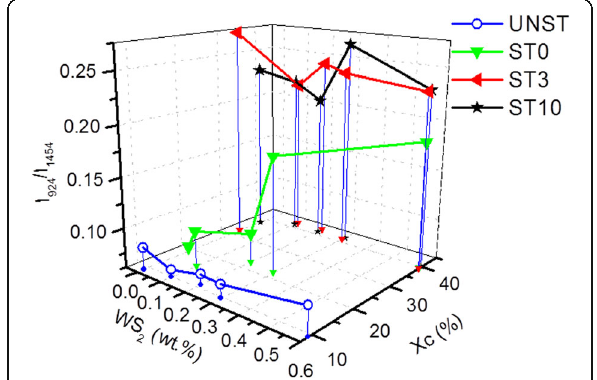
Fig. 9 Degree of crystallinity X c calculated from DSC data and intensity ratio I 924 /I 1454 of Raman bands as function of wt% of WS 2 for ST and UNST samples of PLA and PLA-WS 2